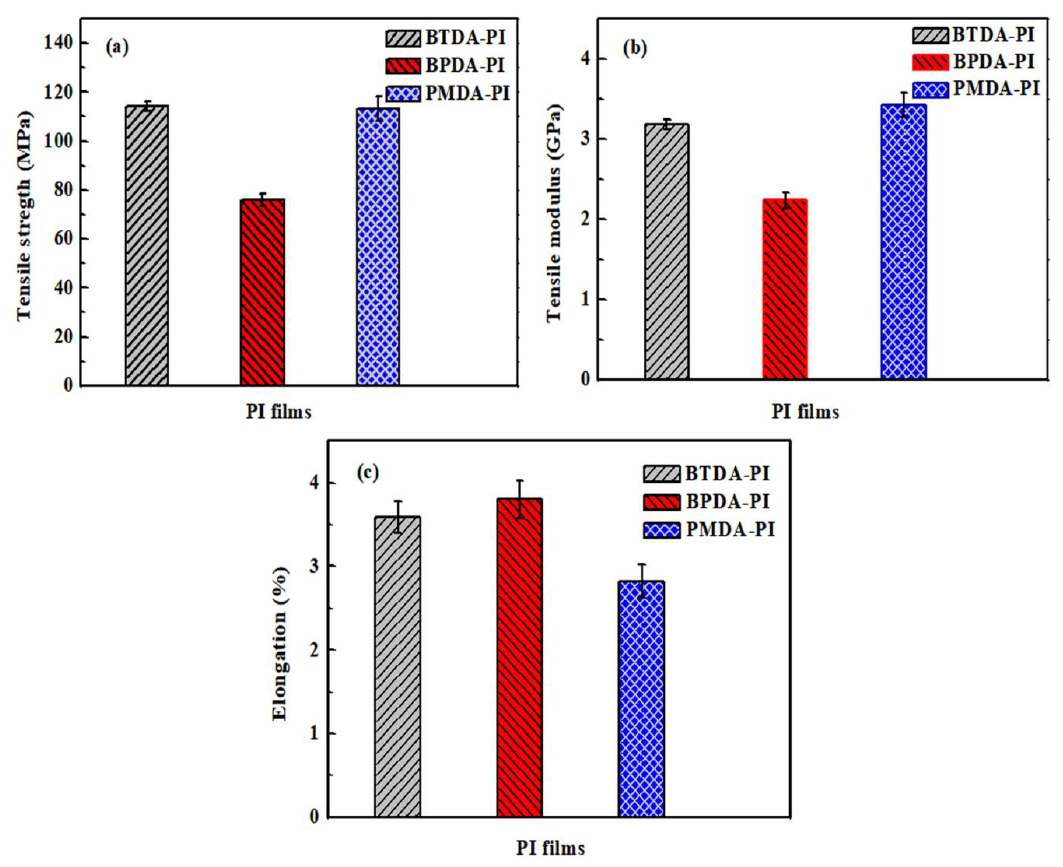
Figure 3. The mechanical properties of PI films: ( a ) tensile strength, ( b ) tensile modulus, and ( c ) percent elongation at break.